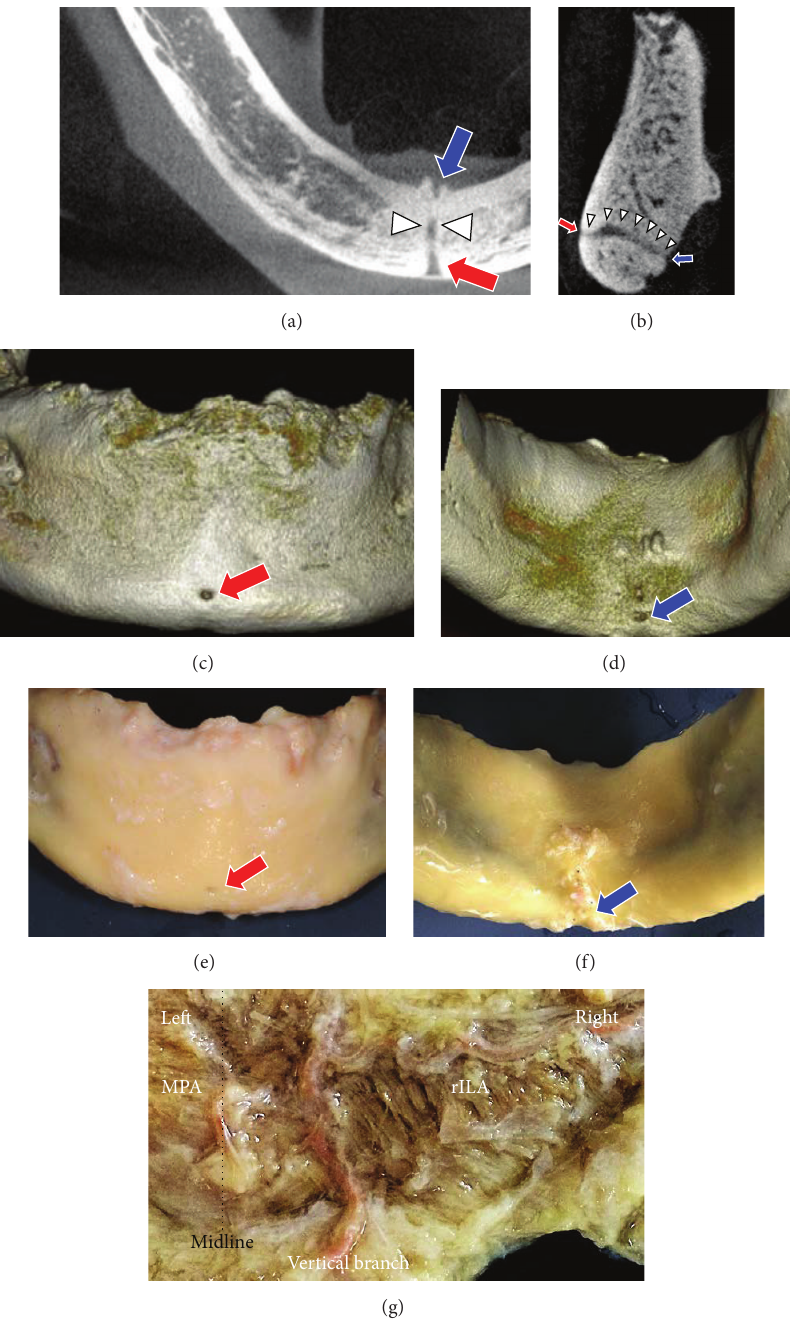
Figure 1: Axial (a) and sagittal (b) images of the mandible show two foramina located on the anterior (red arrow) and posterior (blue arrow) surfaces of the midline. A canal (white arrowheads), which has the continuity of those two foramina, was demonstrated. Three-dimensional computed tomography images of the mandible show anterior (c) and posterior (d) views of the mandible. After removing the overlying soft tissue, the mandible is seen in anterior (e) and posterior (f) views. The medial view of the dissected soft tissue after periosteal detachment shows the right ILA running horizontally and joining the vertical branch, which passes by the inferior border of the mandible (g). The median perforating artery (MPA) has no anastomosis with other branches. Red arrow, median labial foramen (MLaF); blue arrow, median lingual foramen (MLiF); rILA, right inferior labial